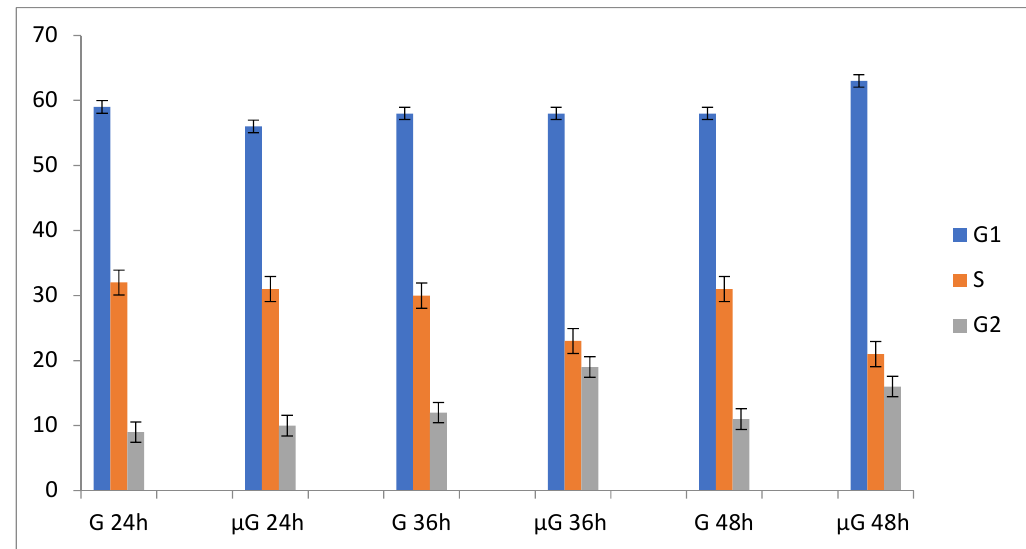
Figure 2. Time course fluctuations in population doubling (PD) and cell cycle phases G1, S, and G2 of A549 cells in normal gravity (G) and in simulated microgravity (µG).